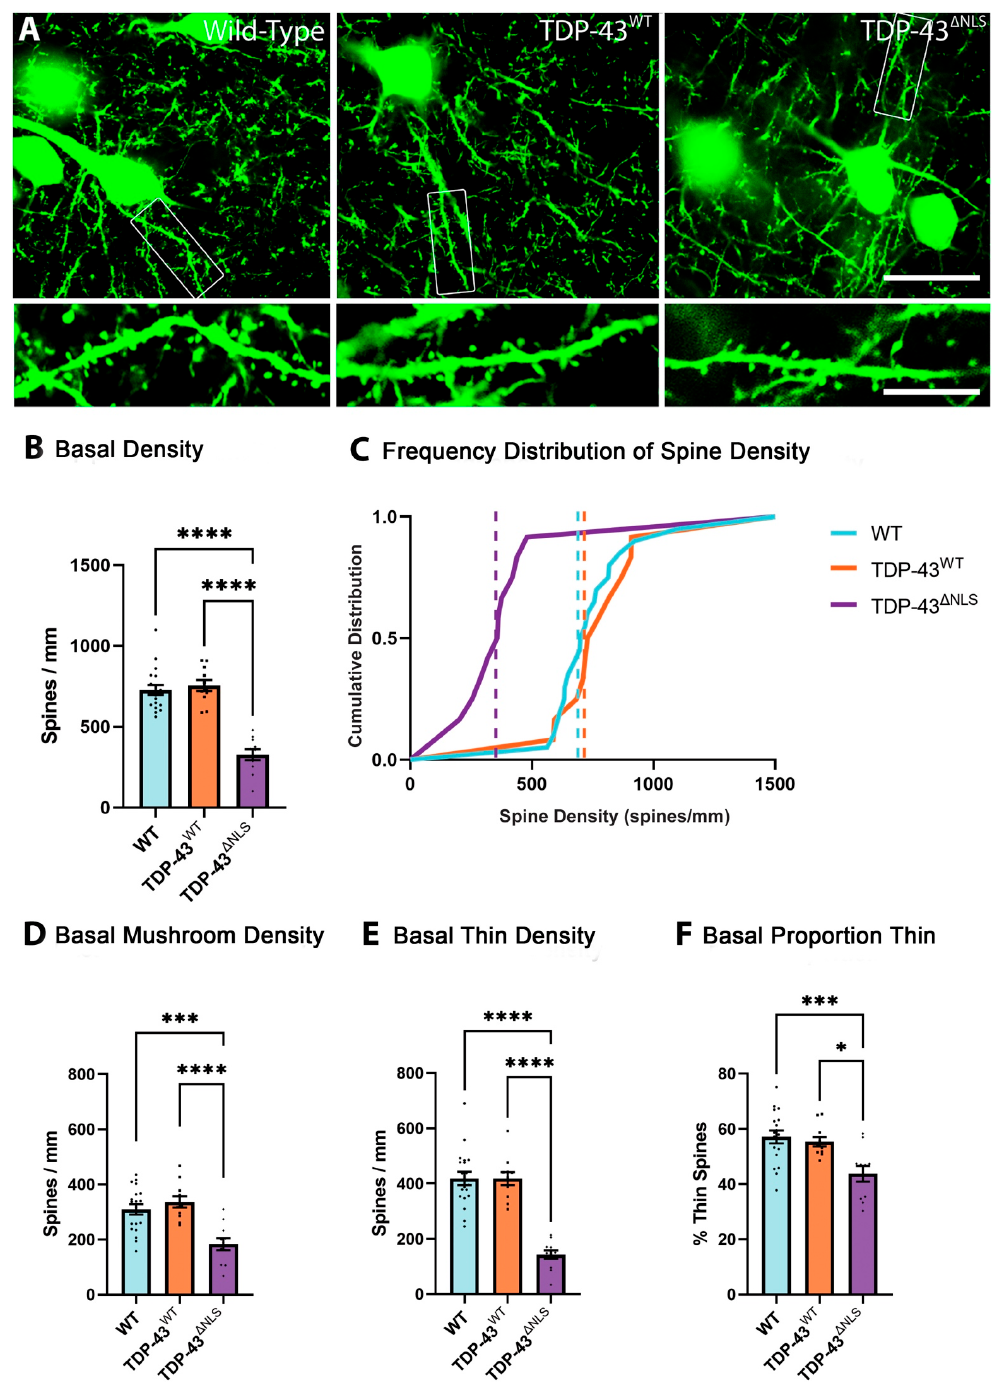
Figure 5. TDP-43 ∆ NLS layer V pyramidal motor neuron basal dendrites have reduced spine density. ( A ). Example images of basal dendrites from WT, TDP-43 WT and TDP-43 ∆ NLS layer V pyramidal neurons of the motor cortex (scale bar 30um, inset 7.5 um). ( B ). Spine density was reduced in TDP-43 ∆ NLS basal dendrites compared to both WT and TDP-43 WT neurons (F (2,38) = 45.9, p < 0.0001). ( C ). Frequency distribution of spine density shows significant leftward shift (decreased spine density) of TDP-43 ∆ NLS basal dendrites. Dotted lines show the median. ( D ). There was a reduced density of mushroom spines in TDP-43 ∆ NLS basal dendrites compared to WT (F (2,38) = 13.3, p = 0.0003) and TDP-43 WT ( p < 0.0001). ( E ). TDP- 43 ∆ NLS basal dendrites have reduced density of thin spines to both WT and TDP-43 WT neurons (F (2,38) = 40.1, p < 0.0001). ( F ). TDP-43 ∆ NLS basal dendrites have a reduced proportion of thin spines (F = 8.57 (2,38) , p = 0.0105 to WT and p = 0.0009 to TDP-43 WT ). * p < 0.05, *** p < 0.001, **** p < 0.0001, one-way ANOVA with Bonferroni multiple